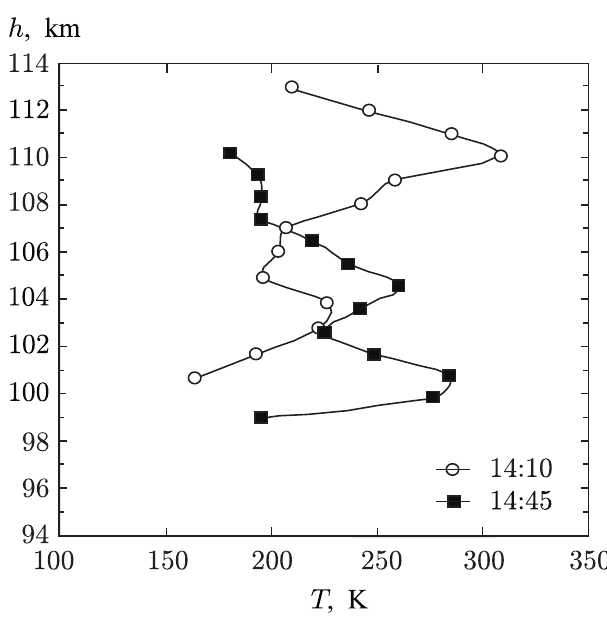
Fig. 4. The temperature vs. altitude pro(cid:12)les of neutral component of the ionosphere for two sessions of measurements on